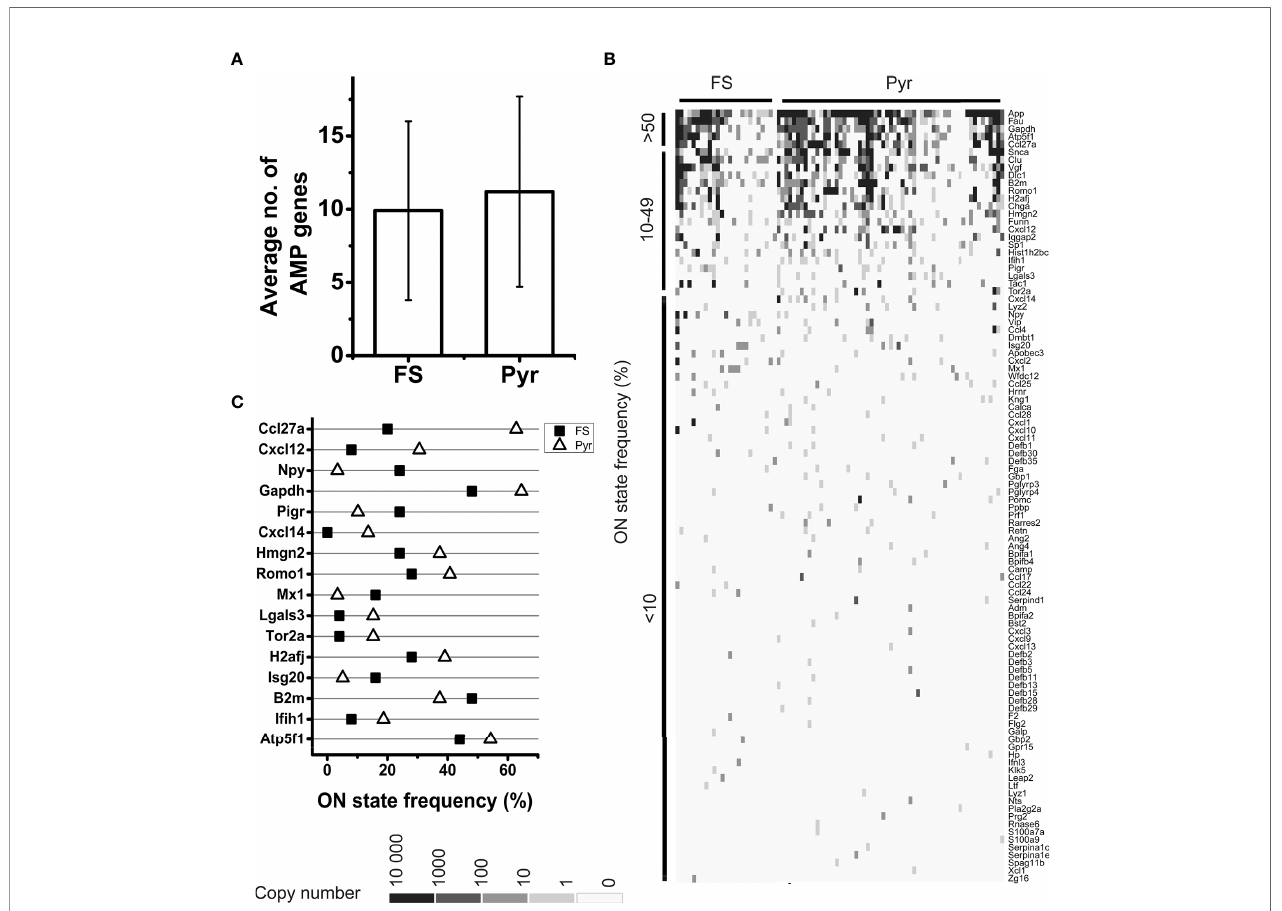
FIGURE 2 | Analysis of AMP mRNA expression by FS and Pyr cells. Bar plot shows the average number of expressed AMP genes in FS and Pyr cells, error bars represent SD (A) . Heatmap of AMP gene expression in single neurons; genes are ordered based on their ON state frequencies; gray scale shows the copy number of mRNAs in each cell (B) . ON state frequencies of genes in FS and Pyr cells are shown; only those genes are listed, which have at least 10% difference in their ON state frequency between the two cell types (C)